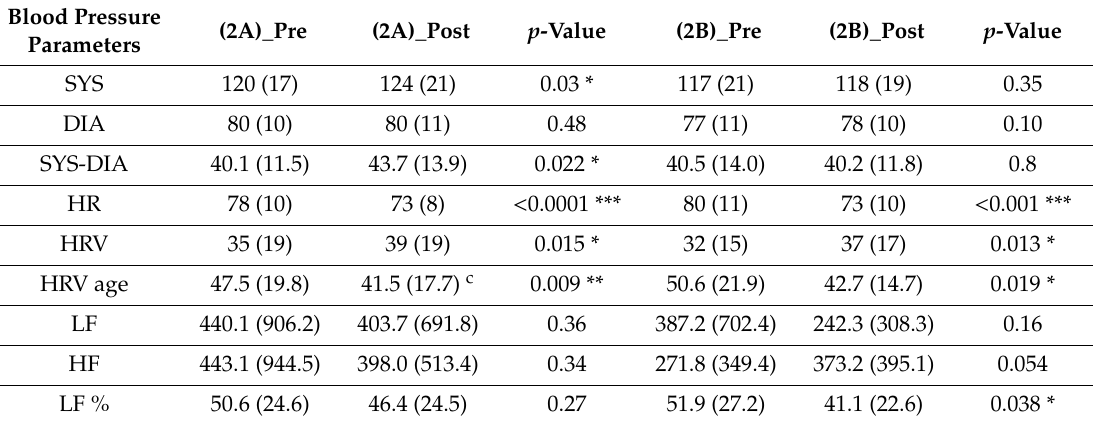
Table 5. Blood pressure waves obtained from experiment